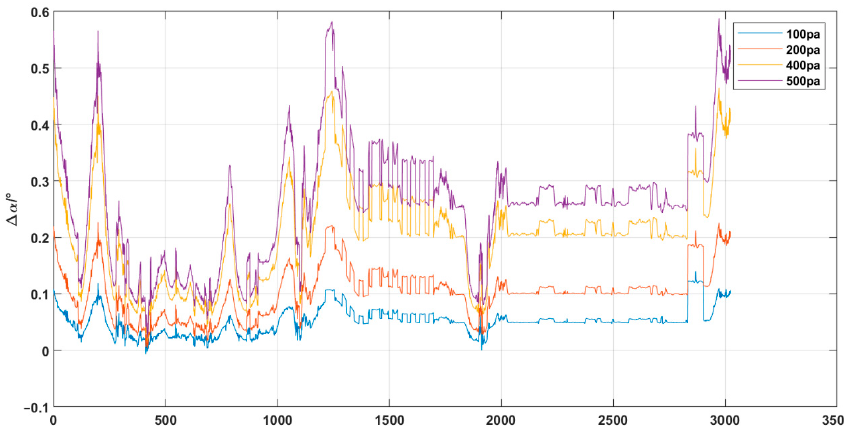
Figure 11. The flowchart of the diagnosis procedures.